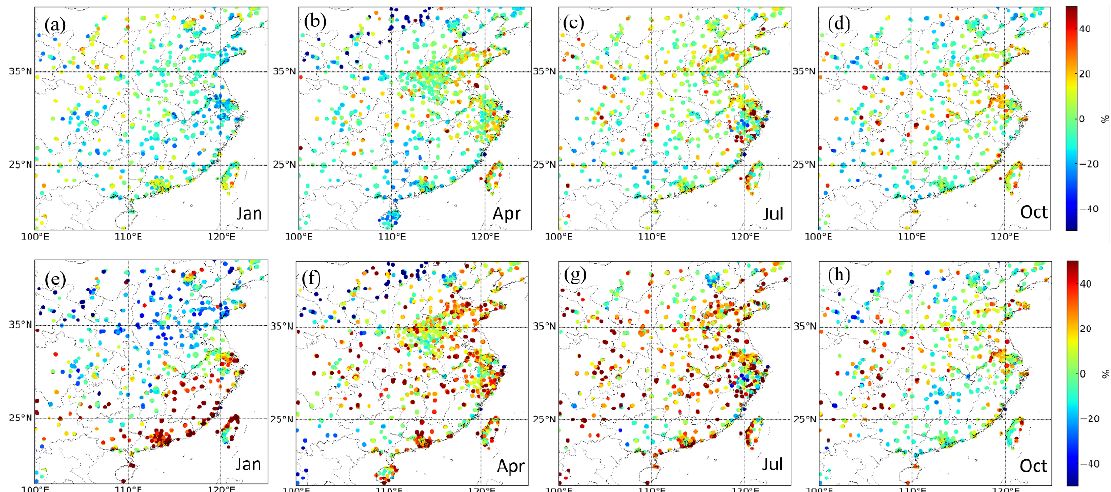
Figure 7. The monthly normalized bias of the estimated PM 2 . 5 average with the ground-based PM 2.5 average (( a – d ) MRE of PM 2.5 by CSEN; ( e – h ) MRE of PM 2.5 by